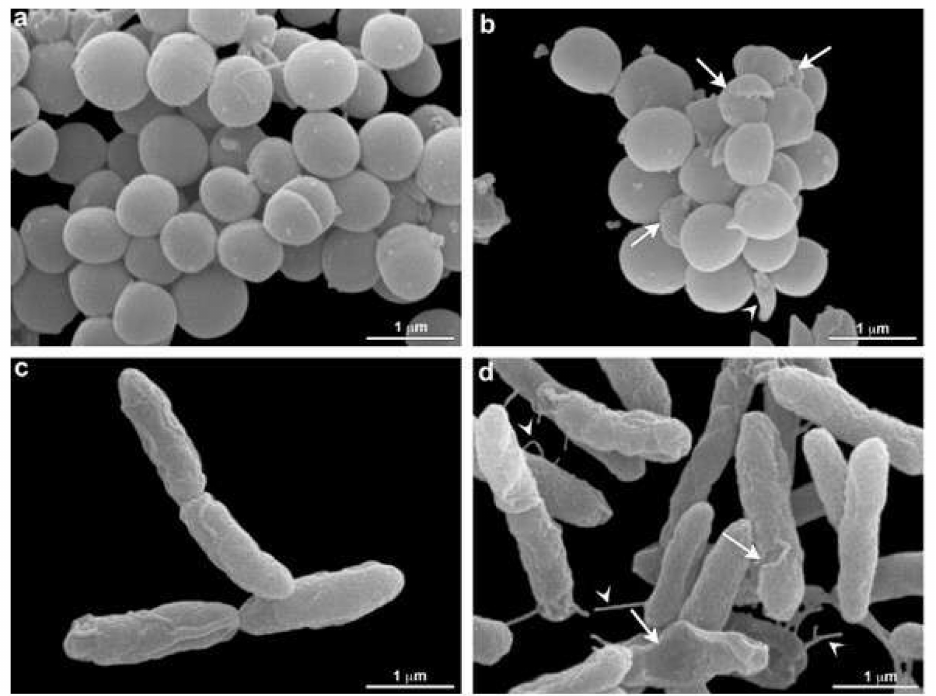
Figure 5. Morphological analysis of O 3 treatment by electron microscopy. S. aureus (MRSA) ( a , b ) and P. aeruginosa (XDR) ( c , d ) are seen without ( a , c ) and under O 3 treatment ( b , d ). An alteration in S. aureus (MRSA) shape is seen (arrowhead) in b. Damage in bacteria is observed after treatment (arrows) ( b ). Note that control cells are rounded and present in a homogeneous surface ( a ). Damaged cells are observed after treatment in P. aeruginosa (XDR) (arrows) ( d ). Some cell wall protrusions are observed in treated cells (arrowhead) ( d ). These aspects were not verified in control cells ( c